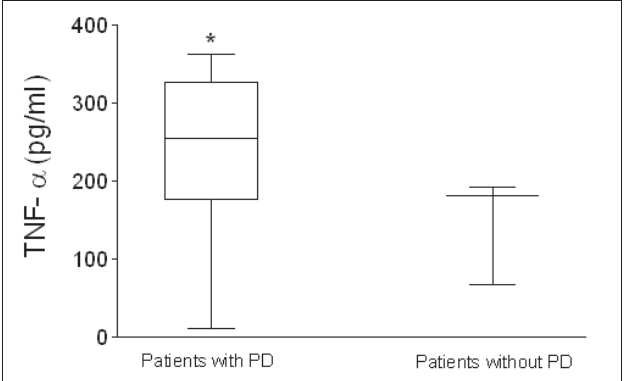
Fig. 1- Levels of TNF- α in plasma of peripheral blood of Down’s syndrome patients with and without periodontal disease. The concentration of TNF- α was evaluated by ELISA. The results are expressed as means ± standard error of means of the values of at least two experiments. *Statistically significant difference (p<